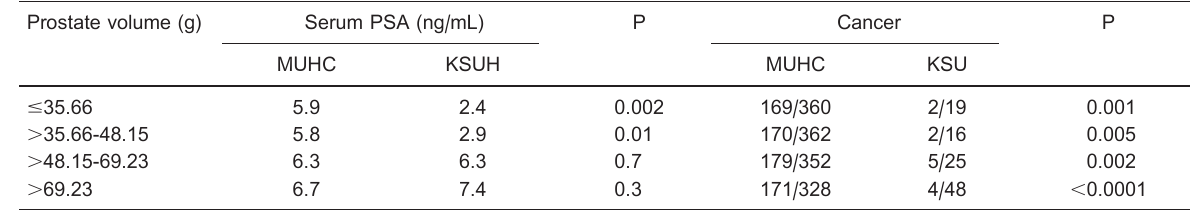
Table 6. Relationship between prostate volume percentile, median PSA level, and cancer detection in the MUHC and KSUH groups. Prostate volume (g) Serum PSA